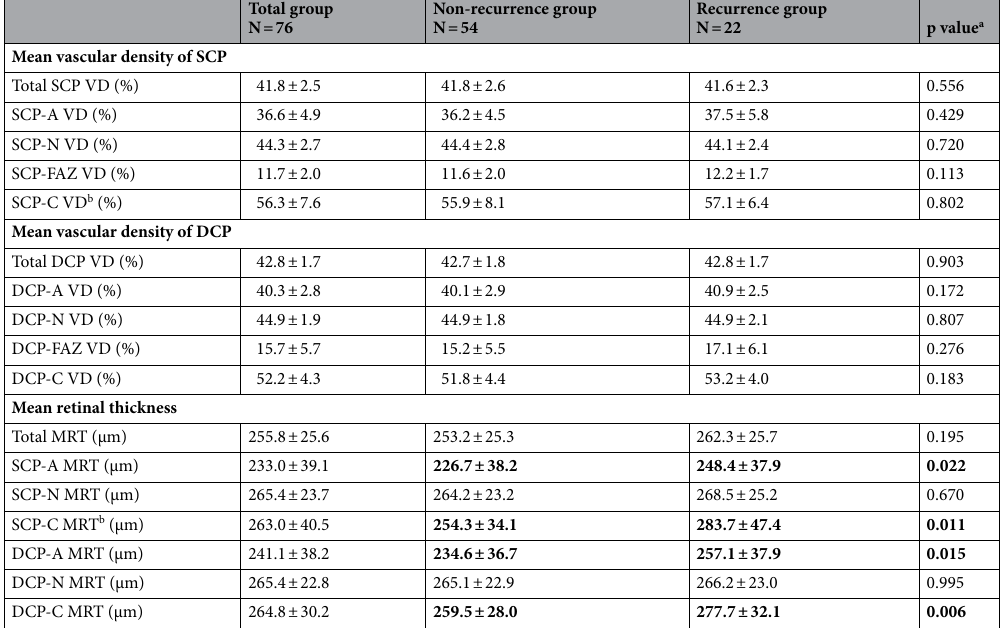
Table 3. Mean vascular density and retinal thickness of the segmented regions. SCP superficial capillary plexus, VD vascular density, SCP-A abnormal region of superficial capillary plexus, SCP-N normal region of superficial capillary plexus, FAZ fovea avascular zone, SCP-FAZ foveal avascular zone of superficial capillary plexus, SCP-C capillary congestion of superficial capillary plexus, DCP deep capillary plexus, DCP-A abnormal region of deep capillary plexus, DCP-N normal region of deep capillary plexus, DCP-FAZ foveal avascular zone of deep capillary plexus, DCP-C capillary congestion of deep capillary plexus, MRT mean retinal thickness. Bold font indicates a statistically significant difference (a p value < 0.05) between the non-recurrence and recurrence groups. a All values are the results of the Mann–Whitney U test. b Statistical values for 67 eyes (47 eyes in the recurrence group and 20 eyes in the non-recurrence group) in which SCP-C was observed.